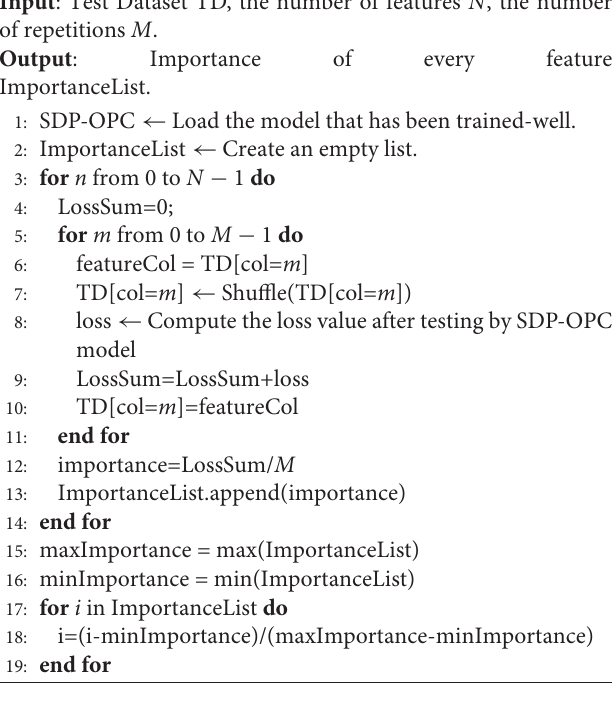
Algorithm 2 Algorithm of computing feature importance based on permutation